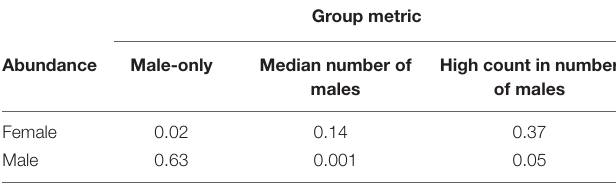
TABLE 1 | Coefficients of determination ( r 2 ) from bootstrapped